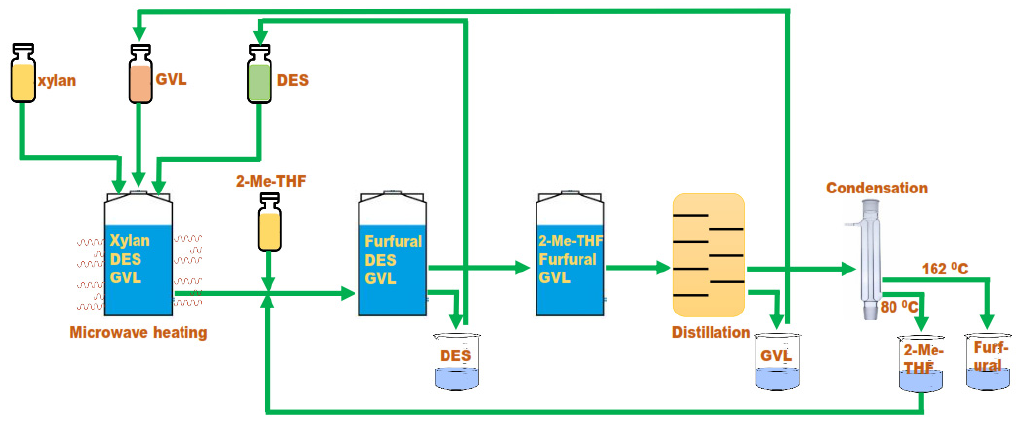
Figure 12. The proposed diagram for recovery of the produced furfural from xylan.